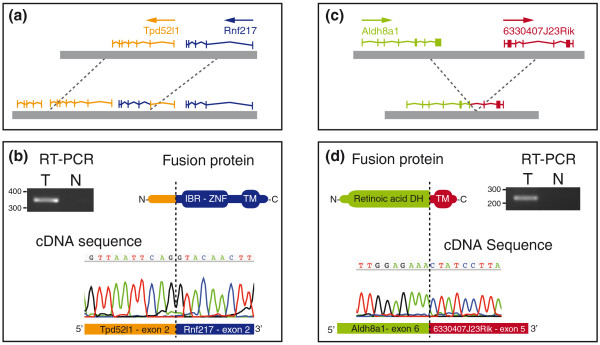
Expressed fusion genes found in tumor PD3680a. (a) Schematic representation of the fusion of genes Tpd52l1 and Rnf217 by tandem duplication. (b) RT-PCR product of RNA between exon 2 of Tpd52l1 and exon 2 of Rnf217. Sequence trace of the RT-PCR product confirming the fusion at the RNA level. A schematic representation of the putative fusion gene product. IBR-ZNF, in between ring fingers-zinc finger domain PF01485; TM, transmembrane domain - predicted by TMHMM. (c) Schematic representation of the fusion of genes Aldh8a1 and 6330407J23Rik by deletion. (d) RT-PCR product of RNA between exon 6 of Aldh8a1 and exon 5 of 6330407J23Rik. Sequence trace of the RT-PCR product confirming the fusion at the RNA level. A schematic representation of the putative fusion gene product. Retinoic acid DH, aldehyde dehydrogenase PF00171; TM, transmembrane domain - predicted by TMHMM.